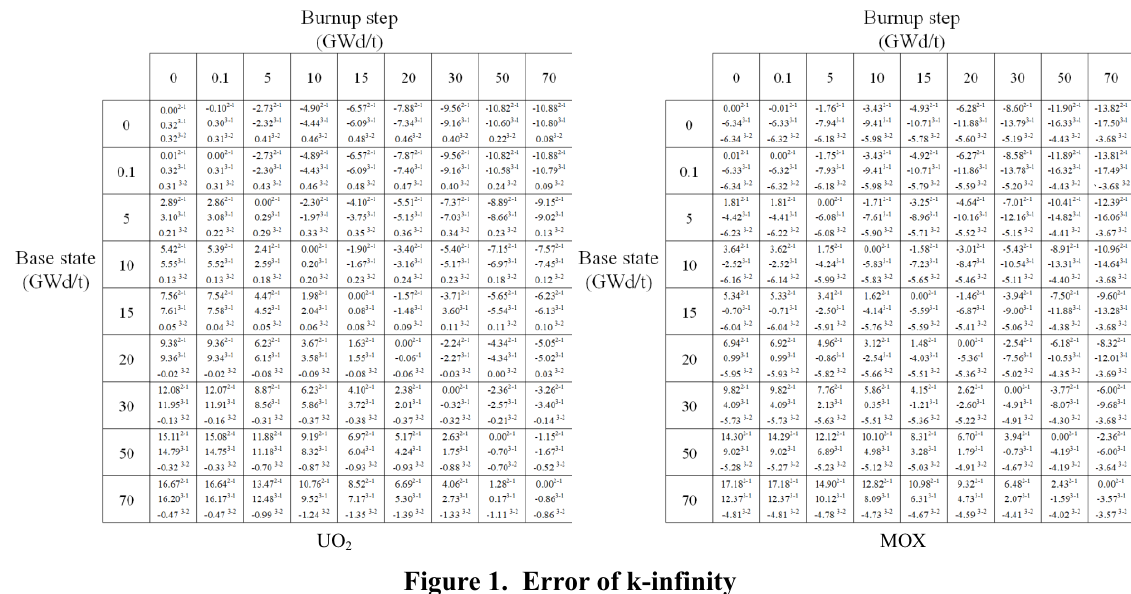
Figure 1. Error of